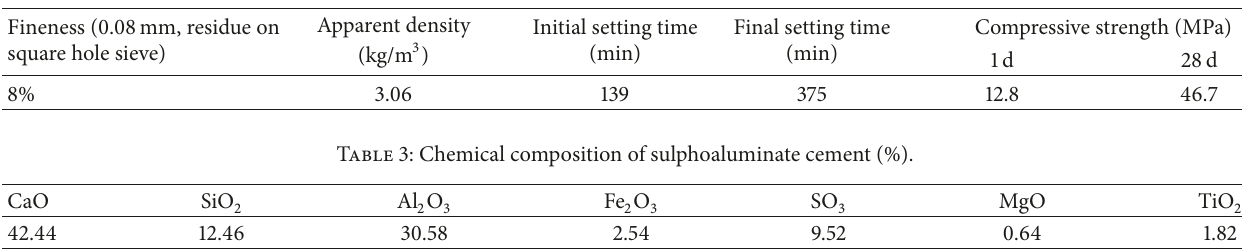
Table 2: Physical parameters of ordinary Portland cement.